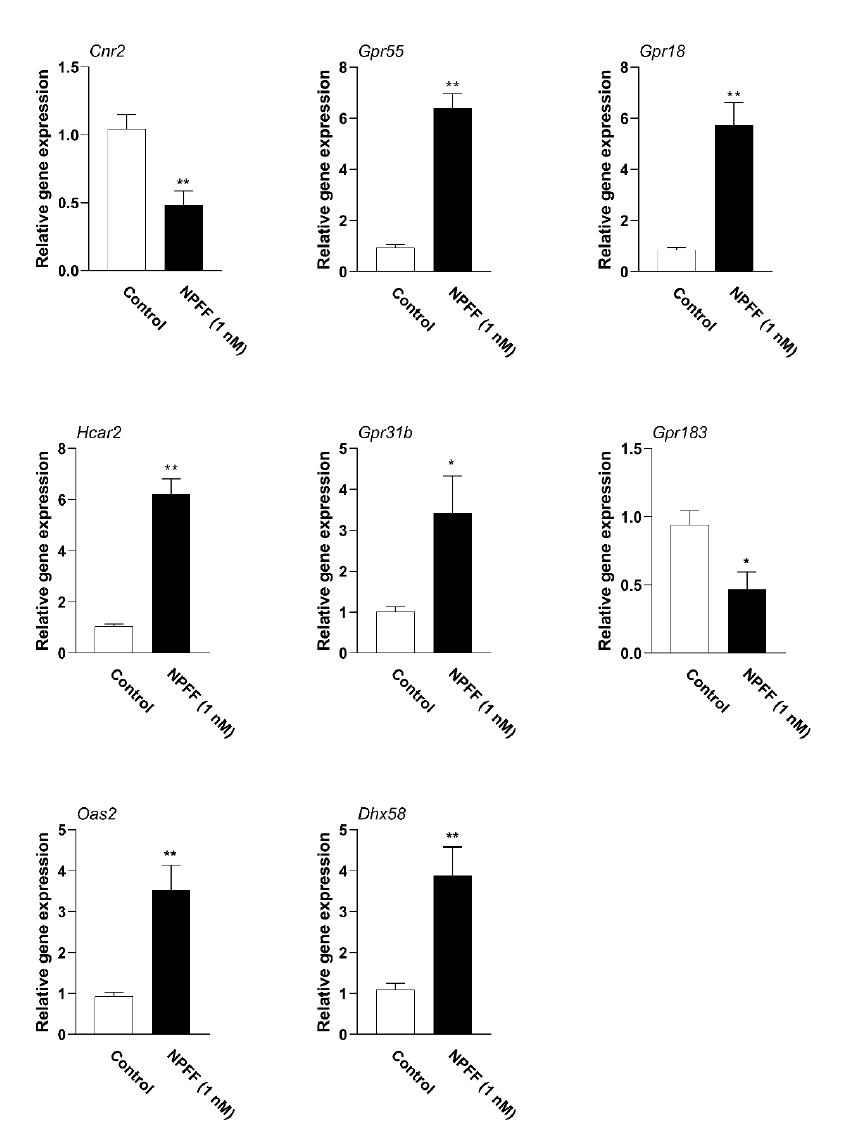
Figure 8. qPCR data for hub genes of BMDMs. BMDMs were incubated with NPFF (1nM) for 18 h, followed by a qPCR examination. Total RNA was isolated, and a qPCR test was conducted to identify eight hub genes. The mRNA level was normalized by the expression of GAPDH. *, significantly different from the control group; * p < 0.05; ** p < 0.01. Each test was performed three times in duplicate. The data were demonstrated as the means ±S.E.M. Statistical significance analysis was carried out using the t-test method.